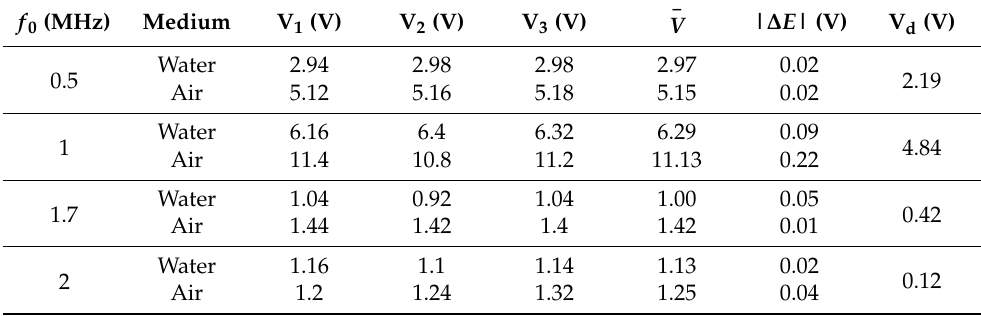
Table 4. Evaluations with different frequencies.